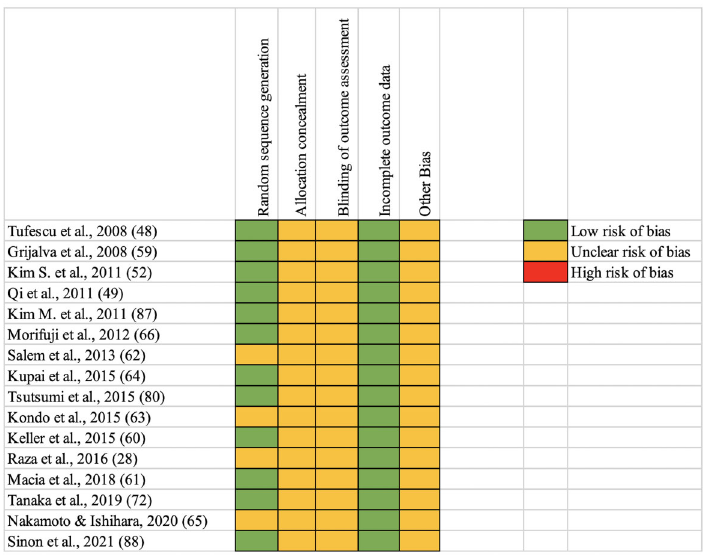
Figure 2. Risk of bias assessments for review studies of exercise intervention in Goto-Kakizaki rats. Low risk of bias: if present, is unlikely to alter the results seriously; unclear risk of bias: a risk of bias that raises some doubt about results; high risk of bias: bias may alter the results